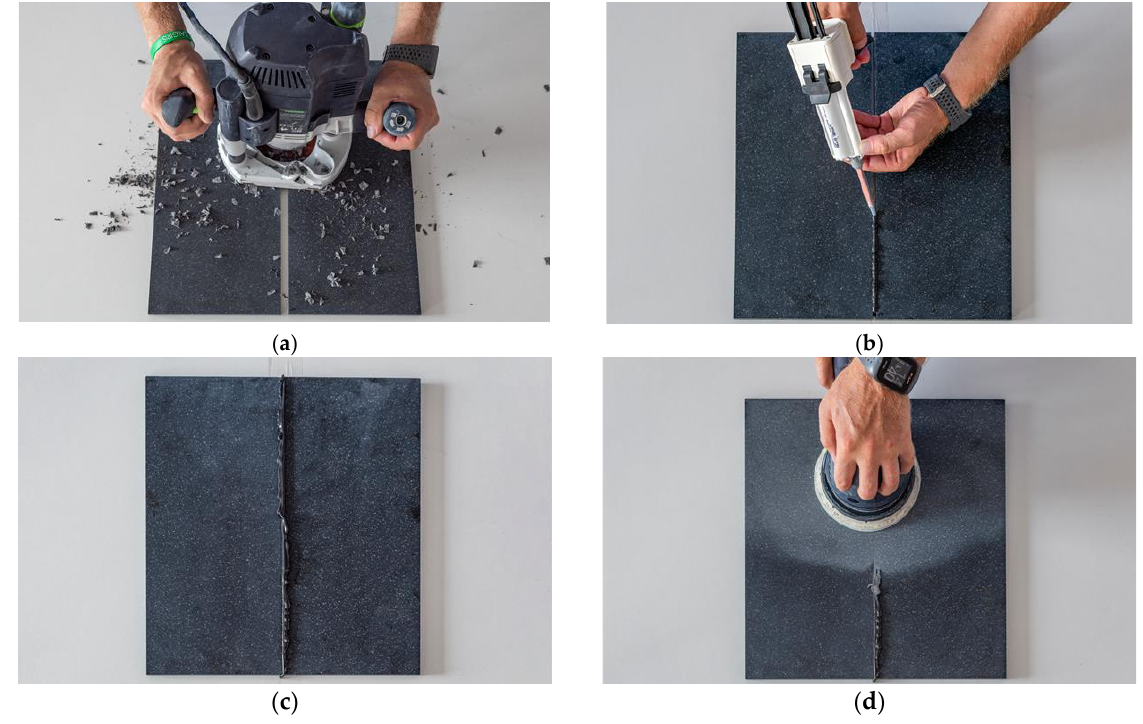
Figure 2. Stages in the process of gluing artificial cast stone: ( a ) levelling of the gluing area; ( b ) gluing; ( c ) drying the glue; ( d ) grinding and polishing.